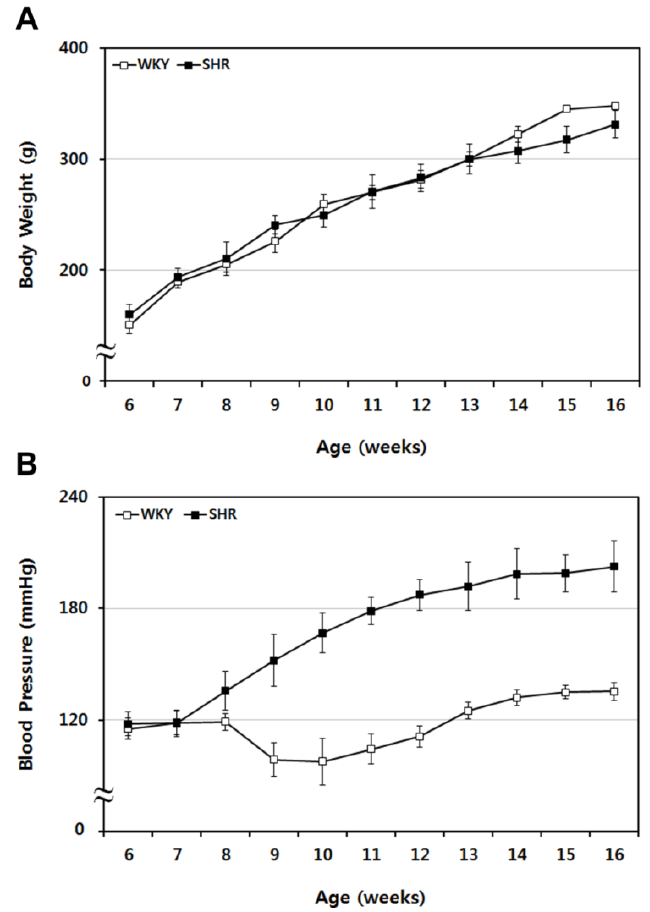
Figure 1. Sequential tracing of body weight and blood pressure in WKY and SHR rats. ( A ) Body weight of WKY and SHR rats was measured for 10 weeks and compared. The two groups showed similar patterns of weight gain. ( B ) Blood pressure in WKY and SHR rats was also assessed periodically over 10 weeks. The systolic blood pressure of SHR rats increased markedly, compared with the normotensive WKY rats. Data shown are means ±